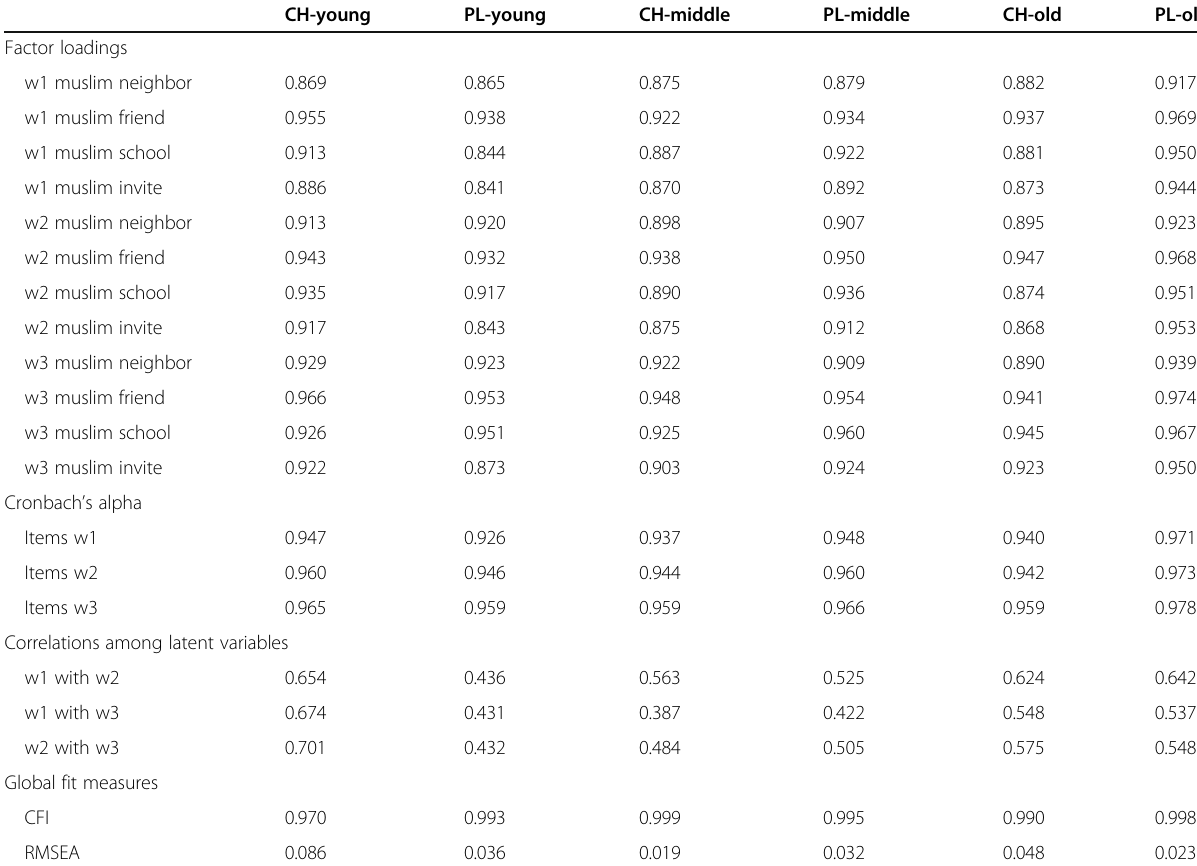
Table 4 SCFA models for attitudes toward Muslim immigrants modeled separately across age cohorts and countries (configural model) (with standardized factor